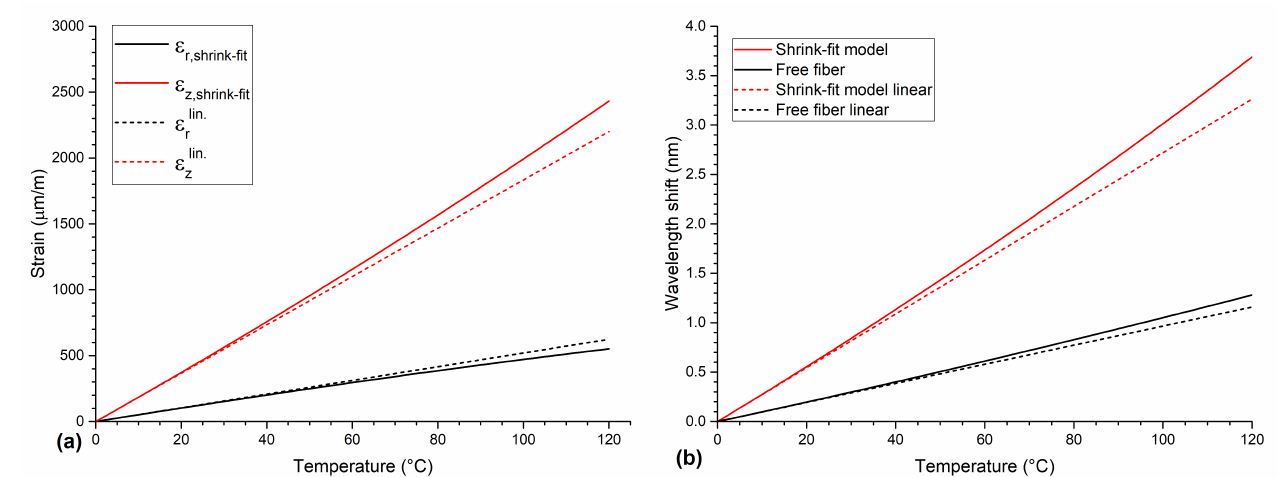
Figure 2. ( a ) Calculated axial (solid red line) and radial strains (solid black line) from the shrink-fit model as a function of temperature. ( b ) Wavelength shift as a function of temperature of the shrink-fit model (solid red line) and free fiber (solid black line). The wavelength shift of the free fiber is significantly lower than that of the embedded fiber. For reference, strain and wavelength shift calculations under the assumption of temperature-independent parameters (at T = 0 ◦ C) are depicted as dashed lines.